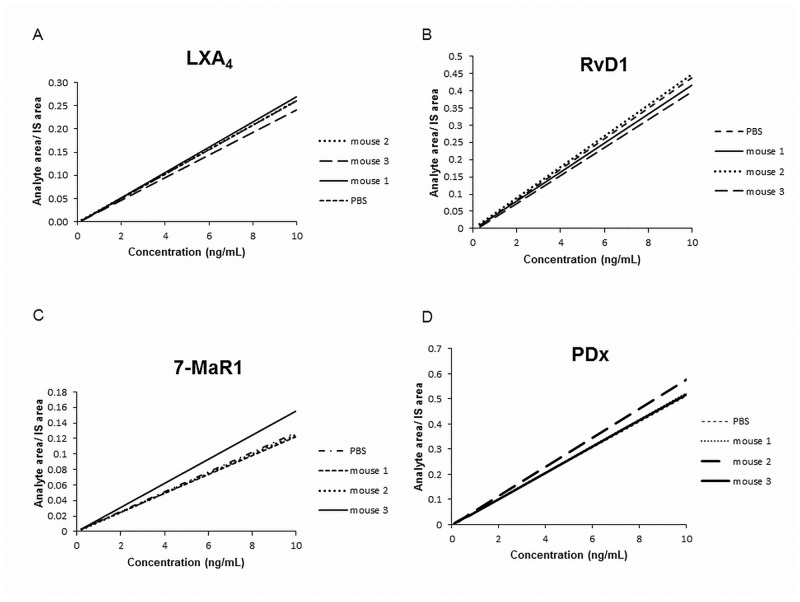
Calibration curves for LXA4, RvD1, PDx and 7-MaR1 in skin (n = 3) and PBS.Calibration curves for each analyte were prepared in skin of 3 different mice as well as PBS and compared. Exemplary curves of LXA4 (A), RvD1 (B), 7-MaR1 (C) and PDX (D) are shown.